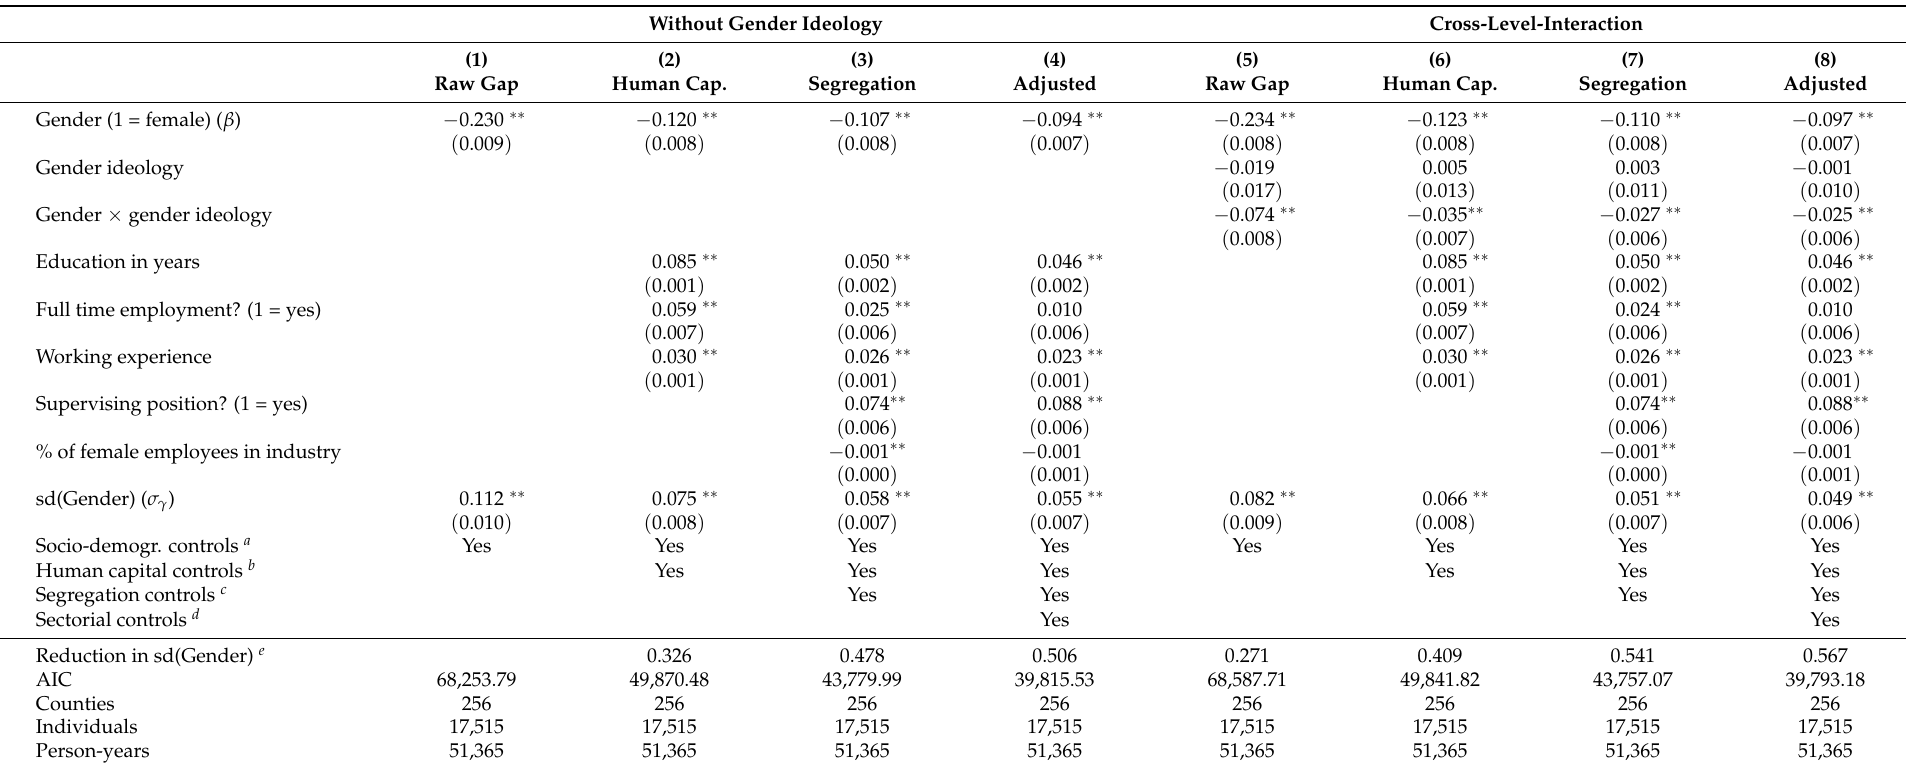
Table 2. Multi-level Models of Log Hourly Gross Wages by Gender, Gender Ideologies, and Adjustment Variables. Without Gender Ideology Cross-Level-Interaction (1) (8) Raw Gap Human Cap. Segregation Adjusted Raw Gap Human Cap. Segregation